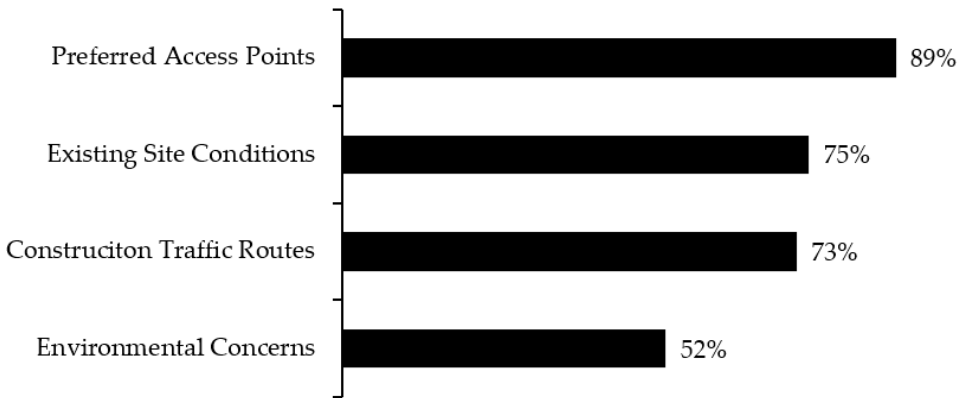
Figure 3. Typical information provided by project